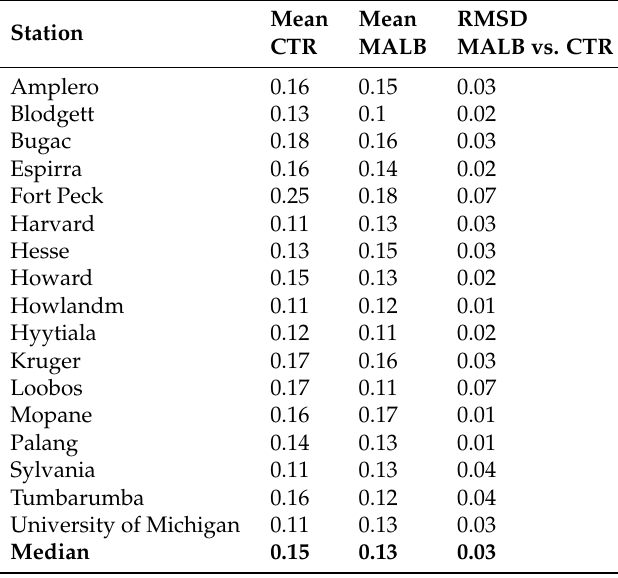
Table 4. Comparison between the CTR and MODIS ALB (MALB) for each tower. The root mean squared difference is computed for the mean annual